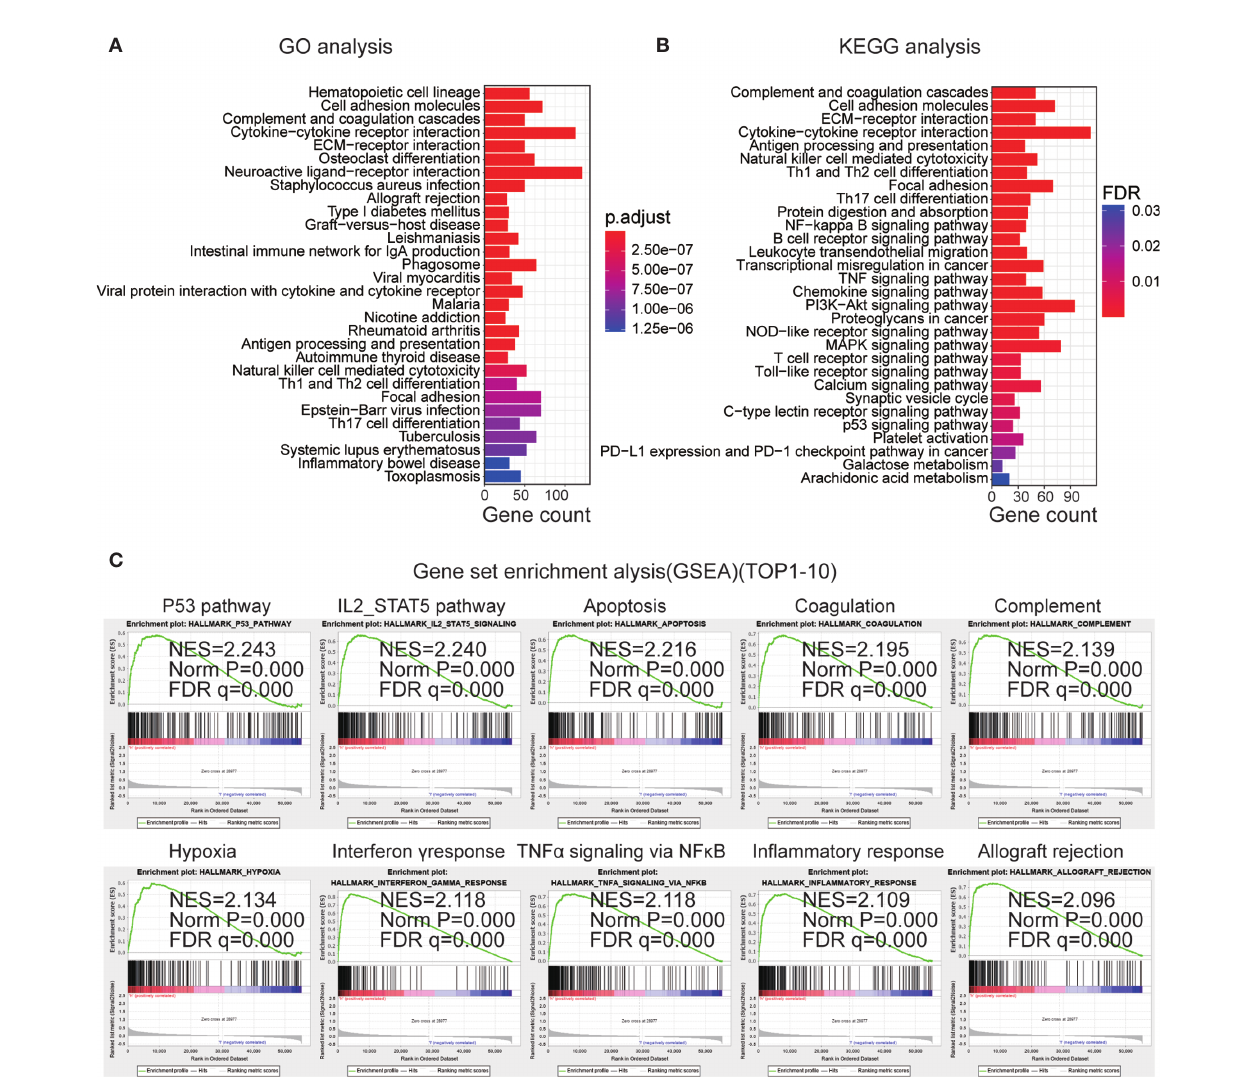
FIGURE 6 | (A) Top 30 gene ontology biological process (GO-BP) analysis enrichment results based on differentially expressed genes. (B) Top 30 Kyoto Encyclopedia of Genes and Genomes (KEGG) pathway analysis enrichment results. (C) Top 10 gene set enrichment analysis (GSEA) results in the high-risk